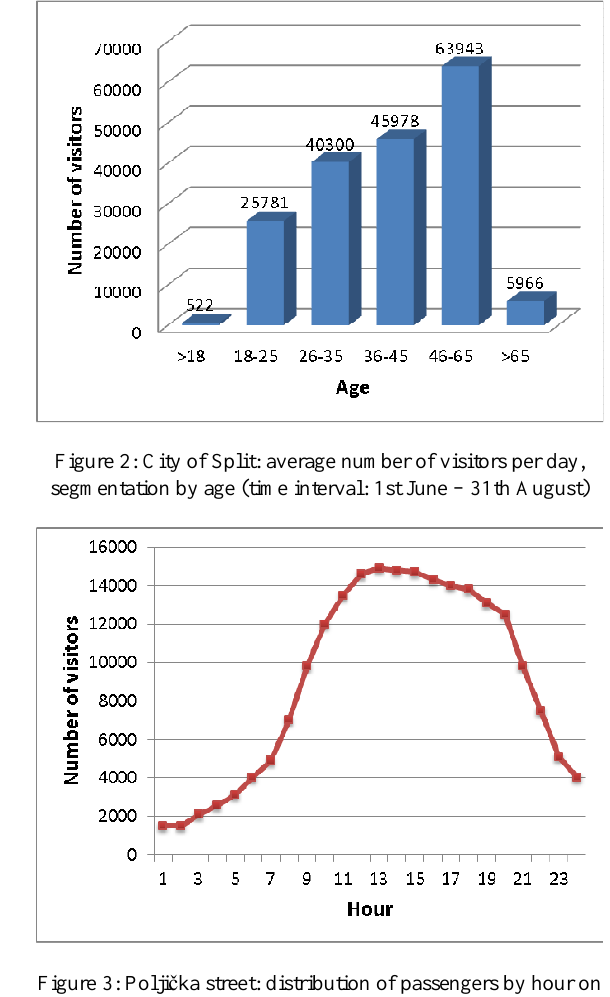
Figure 3: Polji č ka street: distribution of passengers by hour on 3rd August 2015.